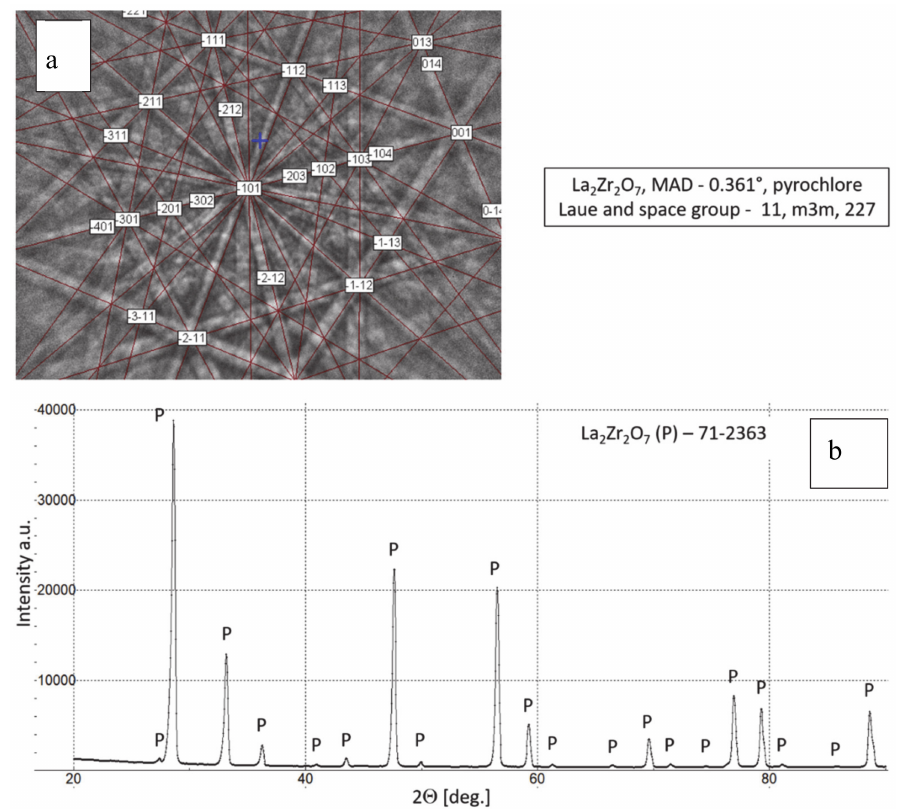
Figure 2. Phase composition of feedstock La 2 Zr 2 O 7 powder, ( a ) Kikuchi lines: EBSD (electron backscattered di ff raction) method and ( b ) XRD (X-ray di ff raction)